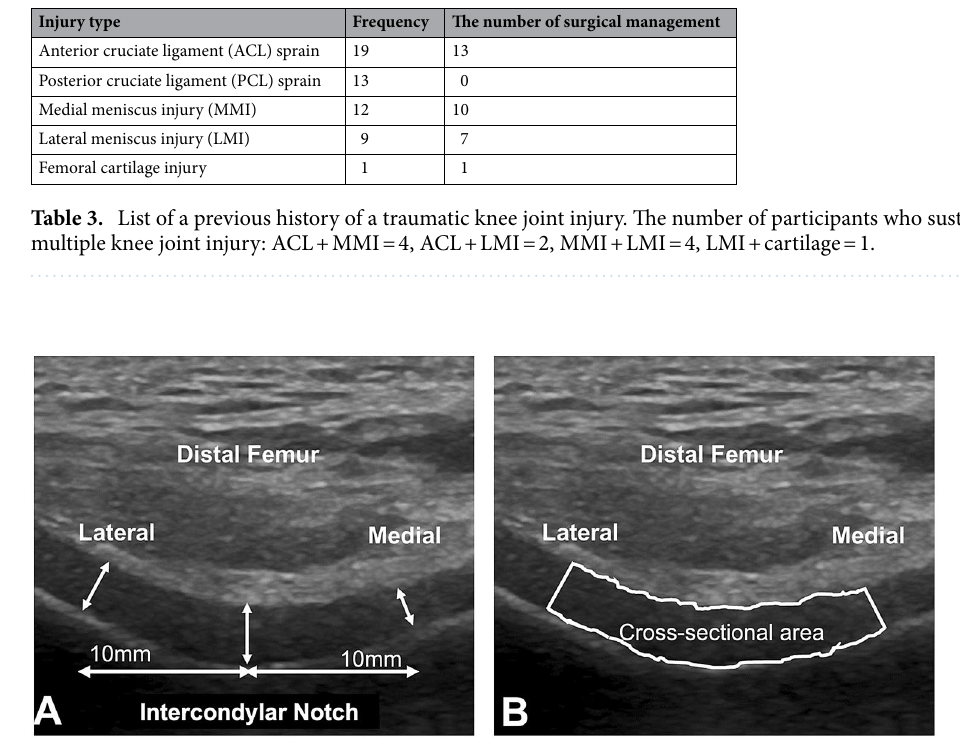
Figure 2. Ultrasonographic image of the anterior femoral articular cartilage: ( A ) Articular cartilage thickness. ( B ) Articular cartilage partial